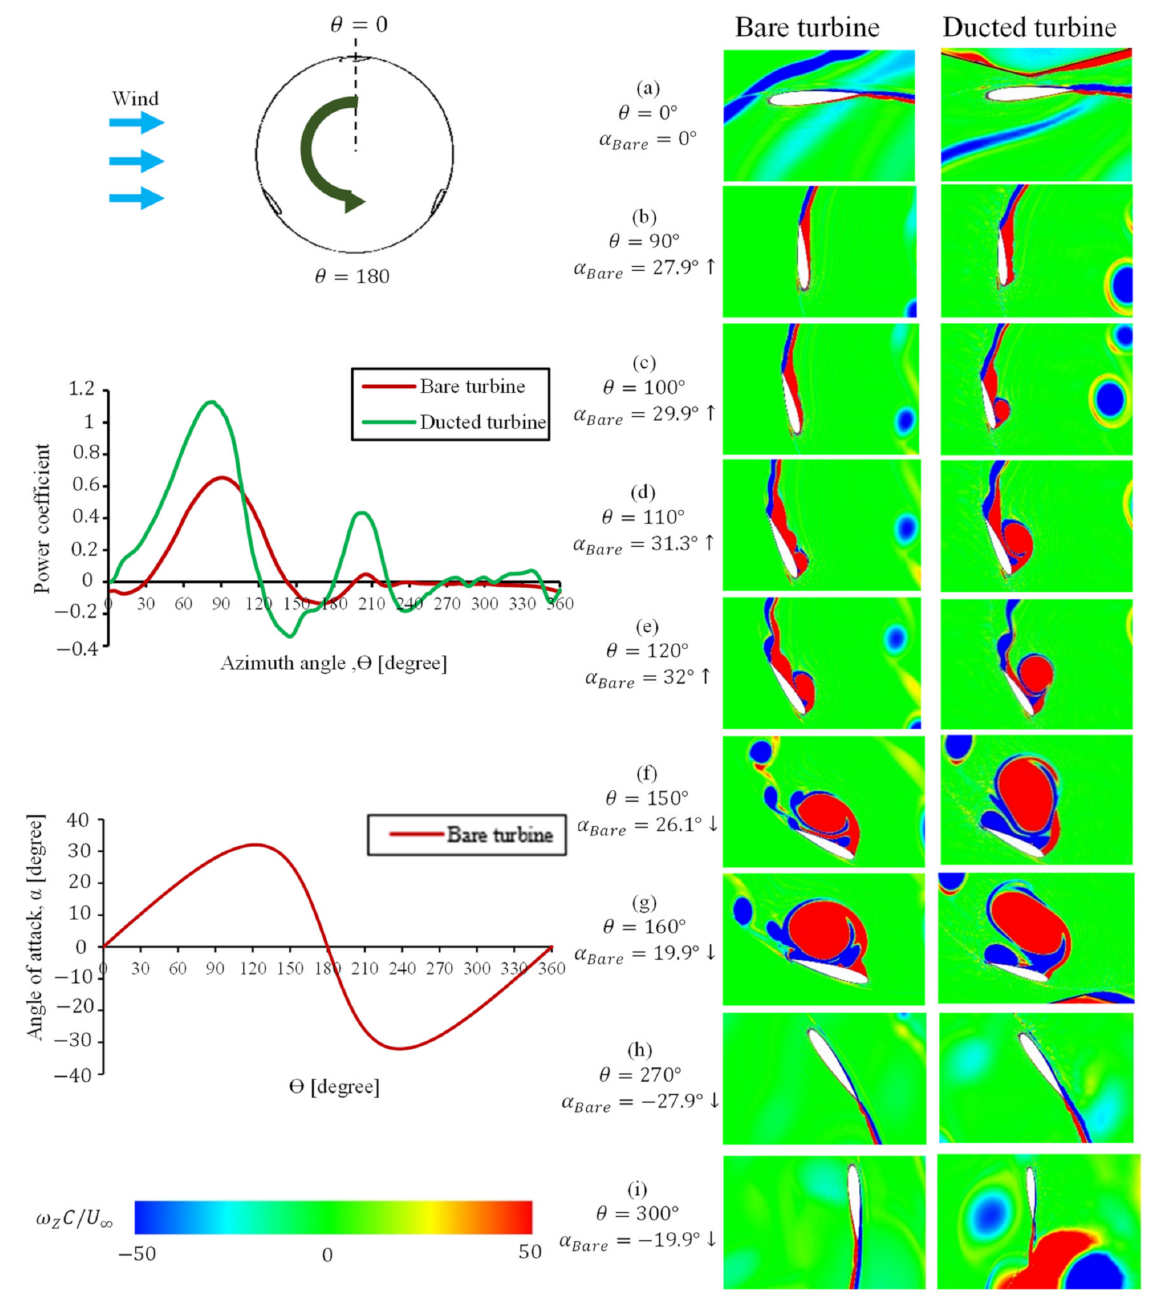
Figure 5. Power coefficient, angle of attack, and vorticity field of one blade in a cycle ( TSR =